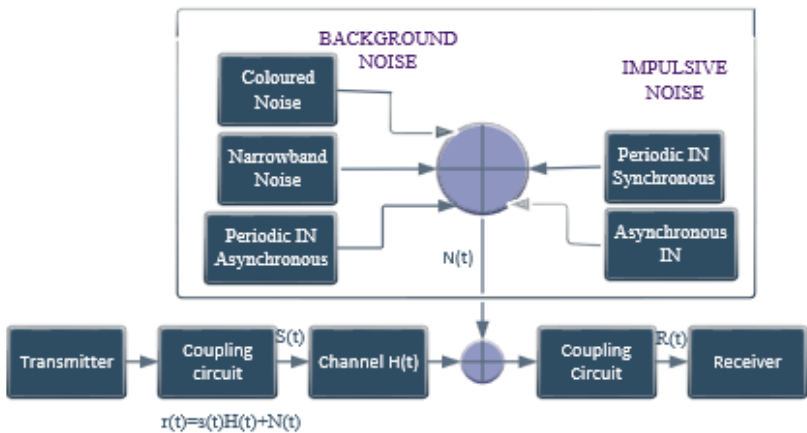
Figure 1. PLC noise